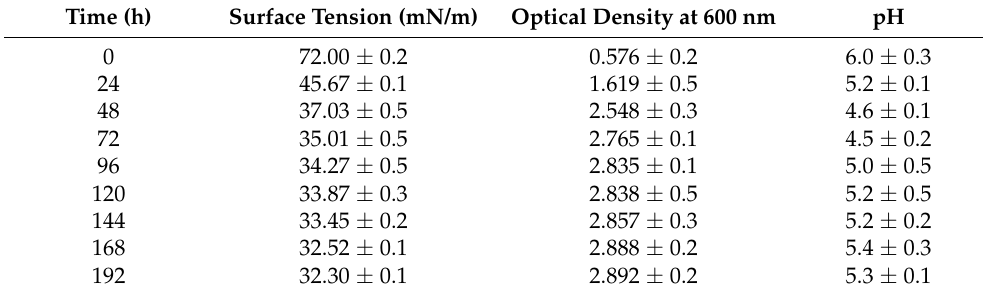
Table 2. Values of surface tension, optical density, and pH during the cultivation of Starmerella bombicola ATCC 22214 for 192 h. Results are expressed as means ± SD ( n = 3), where means are significant at p < 0.05.